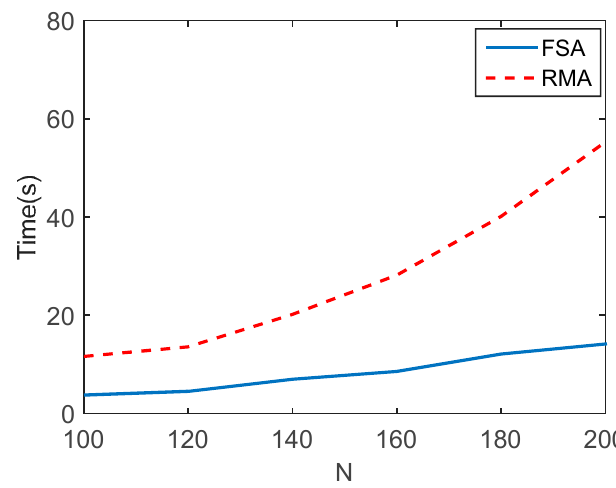
Figure 7. The relationship between imaging time and the number of array elements.